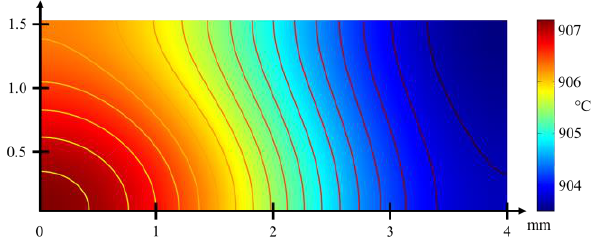
Fig. 5. Calculated temperature distribution and isotherms in graphite at 47.21 ms